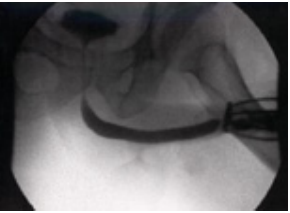
FIGURE 2 . Retrograde urethrogram obtained after the Councill tip catheter was removed. The Councill tip catheter was left indwelling for 3 weeks after removal of the foreign body and repair of the